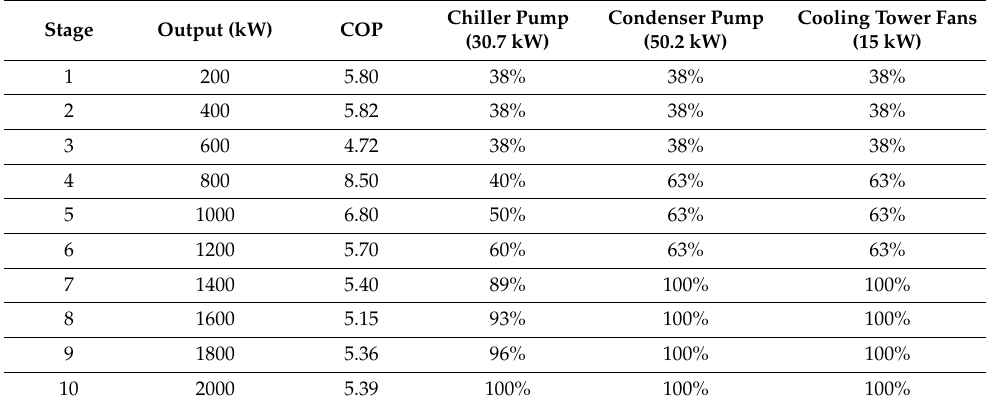
Table 4. Utilized equipment, resulted powers and coefficients of performance (COPs).